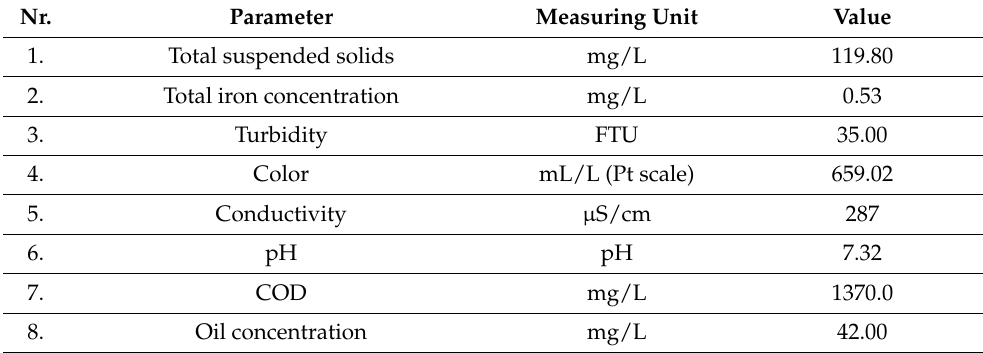
Table 1. The wastewater quality data of investigated samples from tank washing processes.